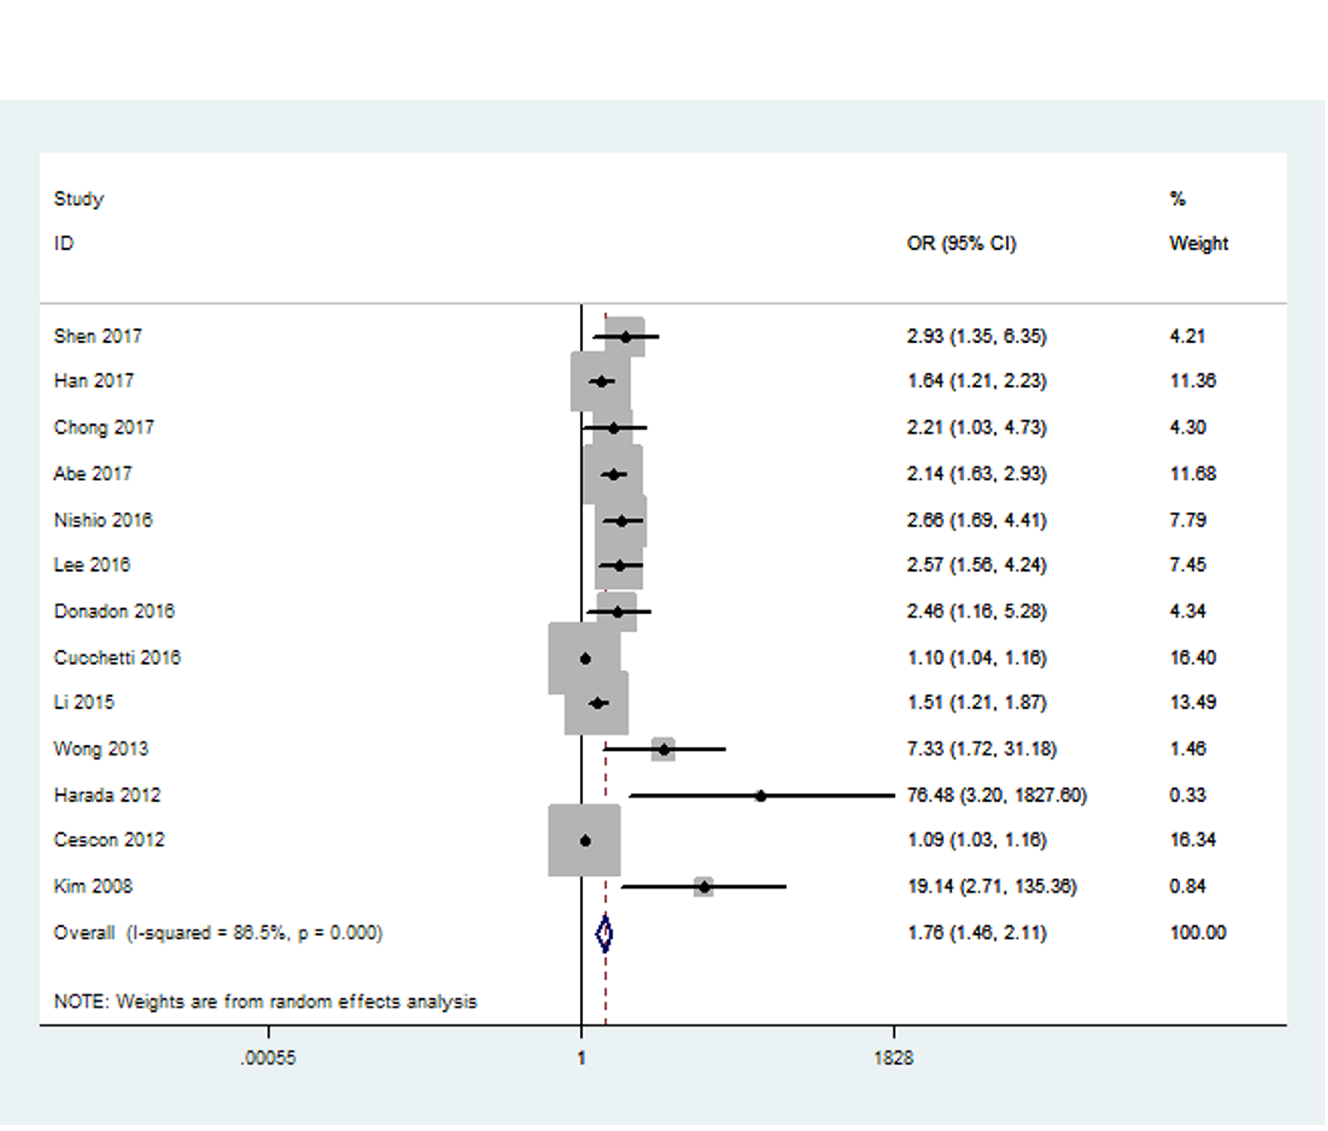
Fig 2. Forest plot on the associations between LSM and overall postoperative complications.